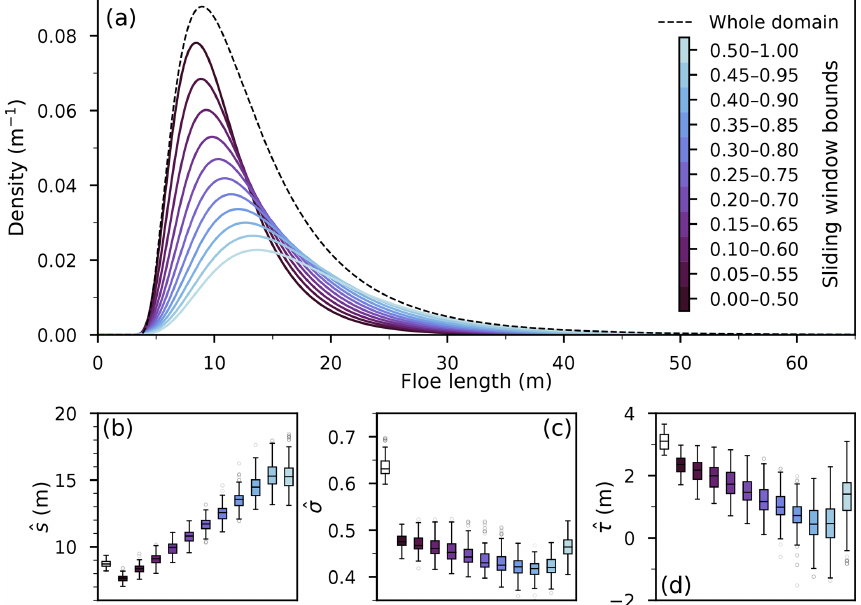
Figure 6. (a) FSDs, fitted to lognormal distributions, in the whole domain and various sub-domains, as described in the text. The area under the partial FSDs is scaled by the number of observations, so that summing the first and the last windows, covering non-overlapping halves of the domain, yields the whole domain FSD. The effective number of floes, relative to the total number of floes in the domain, decreases steadily from 0 . 64 to 0 . 36. Densities averaged over 500 realisations. (b–d) Variation in the estimated parameters among the 500 realisations. In each panel, the white leftmost box corresponds to the whole domain; the coloured boxes follow the colour bar in panel (a)